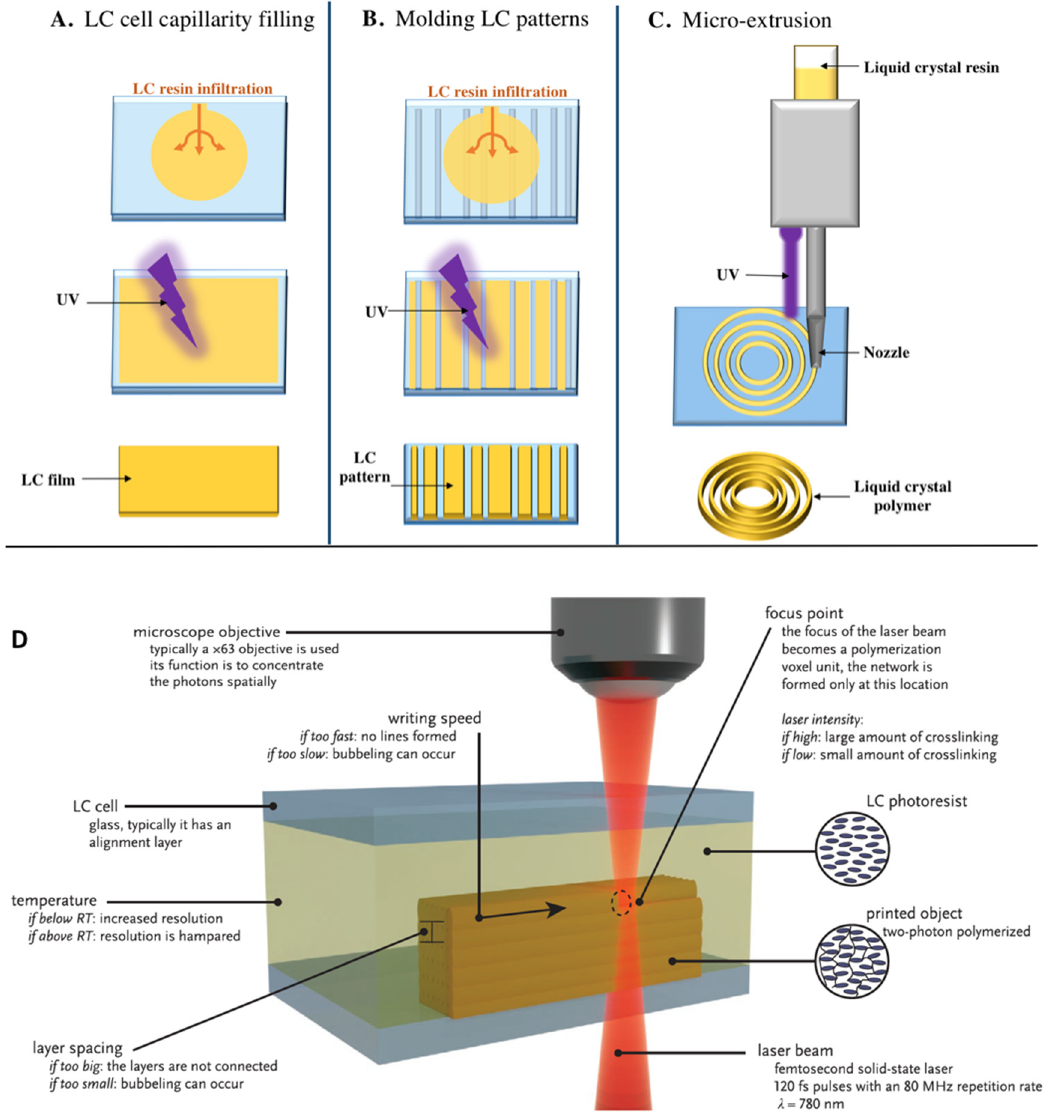
Figure 5. ( A – C ) Different techniques for the impression of objects at the micro-scale involving a photopolymerization reaction. ( D ) TPP applied to an LC pre-oriented cell [53]. Reproduced under